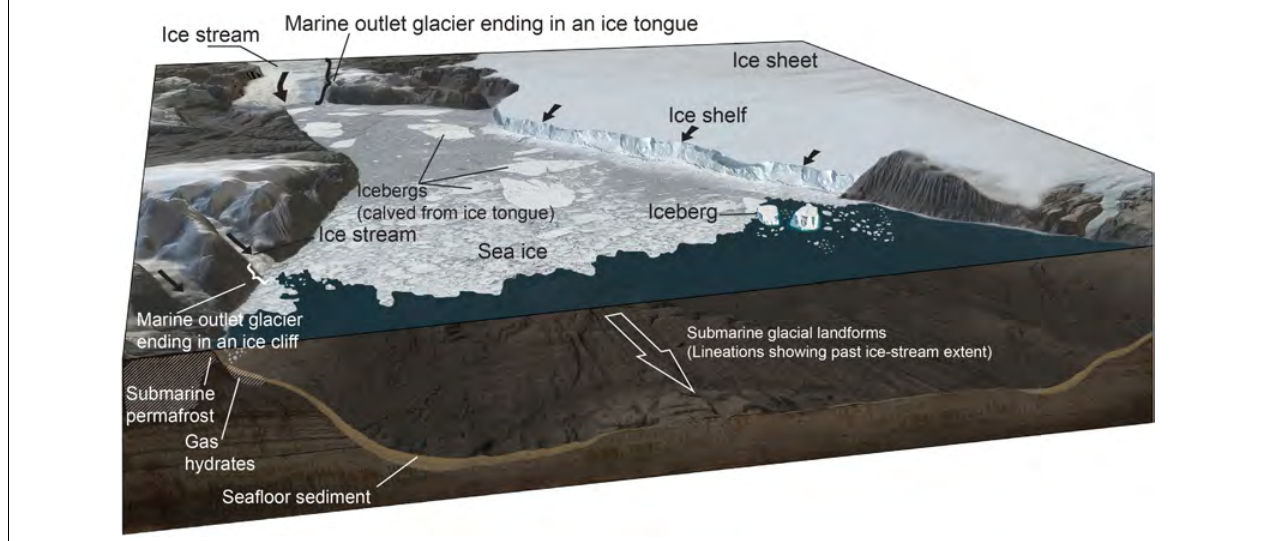
FIGURE 1 | The main components of the “marine cryosphere,” here defined as including marine outlet glaciers ending in floating ice tongues/shelves or grounded ice cliffs, icebergs, ice sheets with their base suppressed below sea level, sea ice, gas hydrates and submarine permafrost. The floating extensions of marine outlet glaciers found in fjords are here referred to as ice tongues, while the wider floating extensions, primarily existing today in Antarctica, are called ice shelves. Permafrost and gas hydrates are part of the marine cryosphere, but not discussed much further in this